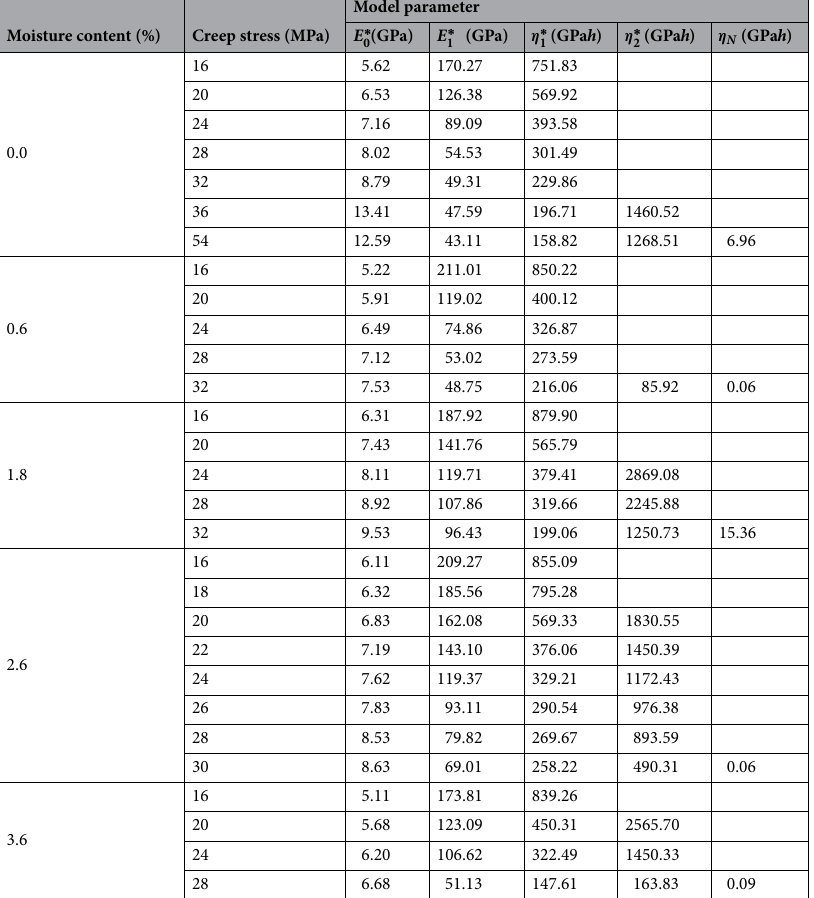
Table 3. Fitted parameters of nonlinear damage creep